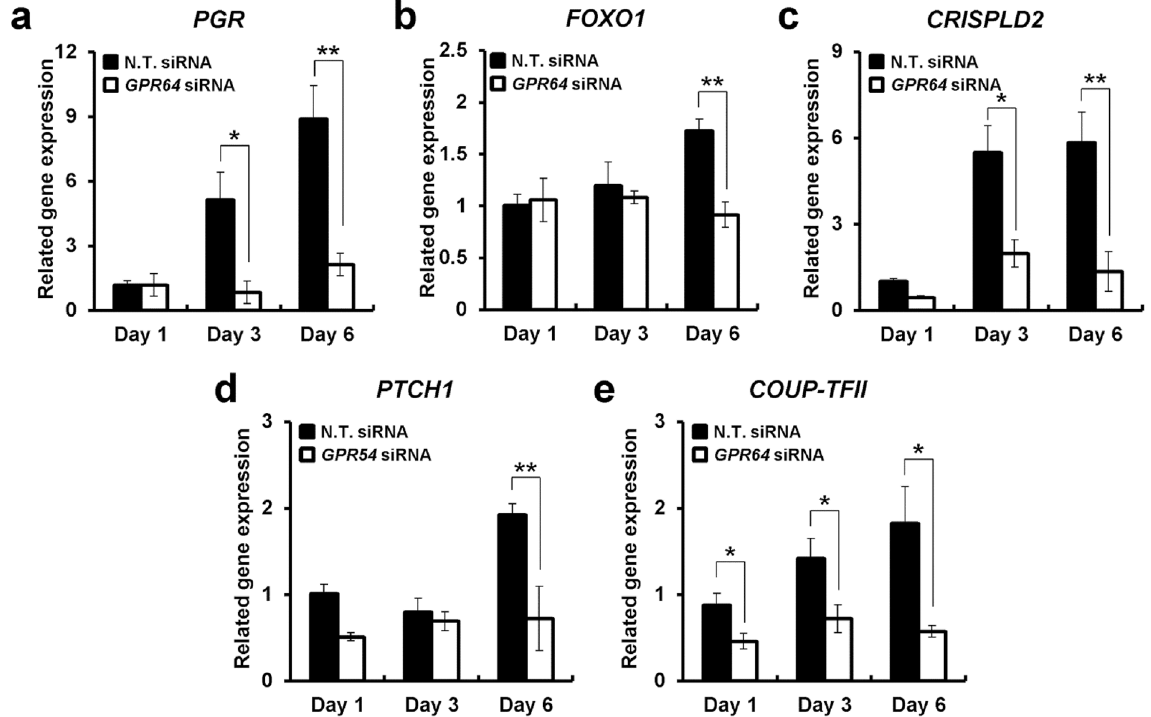
Figure 6. The expression of PGR target genes by reduction of GPR64 during in vitro decidualization of hESCs. The expression levels of PGR ( a ), FOXO1 ( b ), CRISPLD2 ( c ), PTCH1 ( d ), and COUP-TFII ( e ) during in vitro decidualization of hESCs treated with or without GPR64 siRNA by quantitative real-time PCR. The results represent the mean ± SEM. * p < 0.05 and ** p <